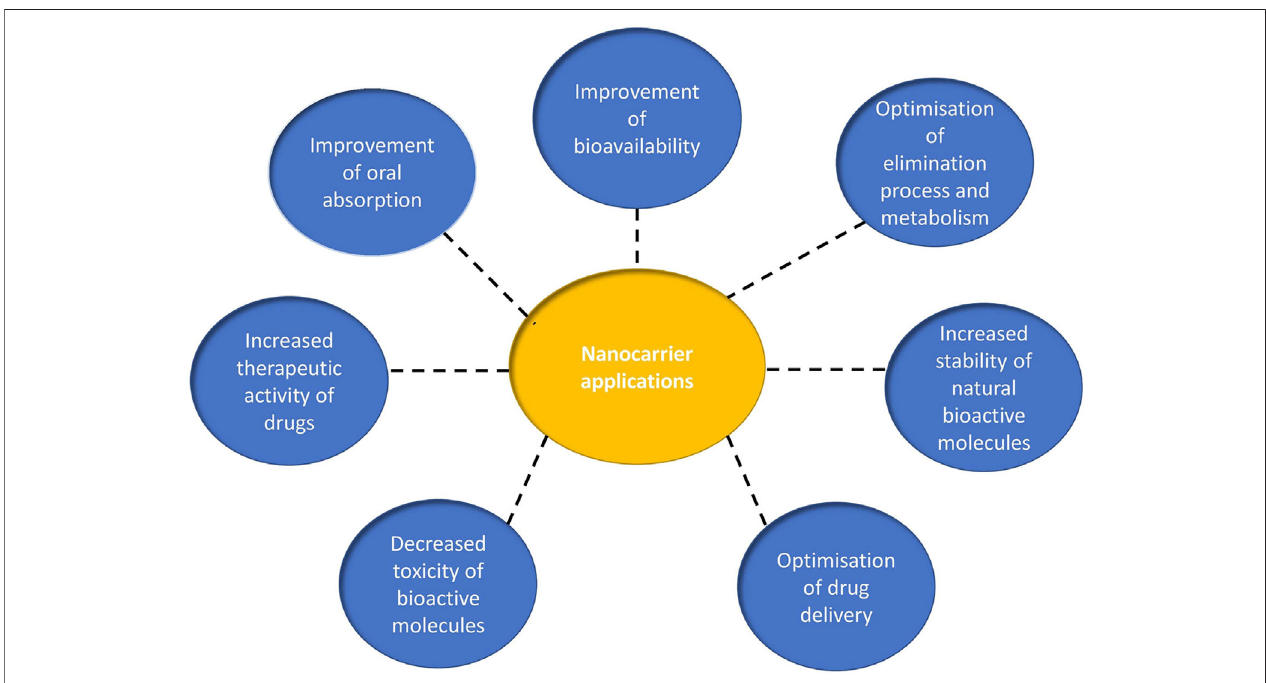
FIGURE 3 | Schematic presentation of the biological activity of nanocarriers as delivery systems for bioactive molecules.